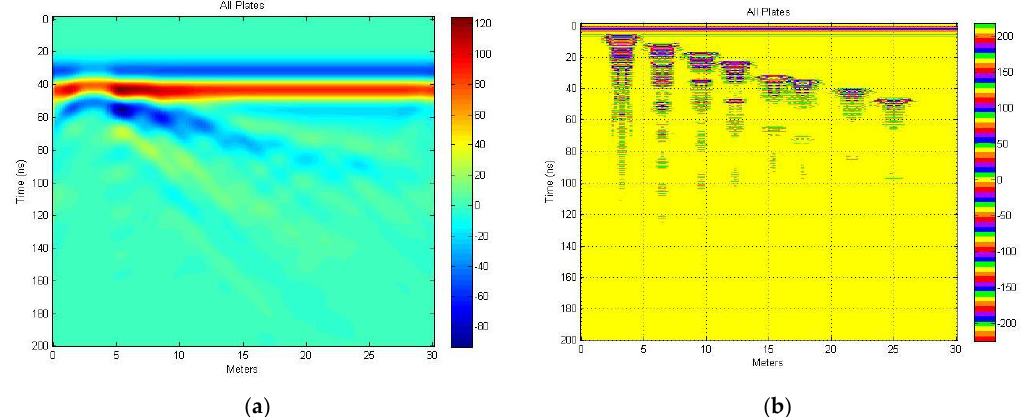
Figure 5. Finite-difference time-domain (FDTD) analysis results of the 2-D model using GprMax at 25 MHz ( a ) and 900 MHz ( b ) [1].